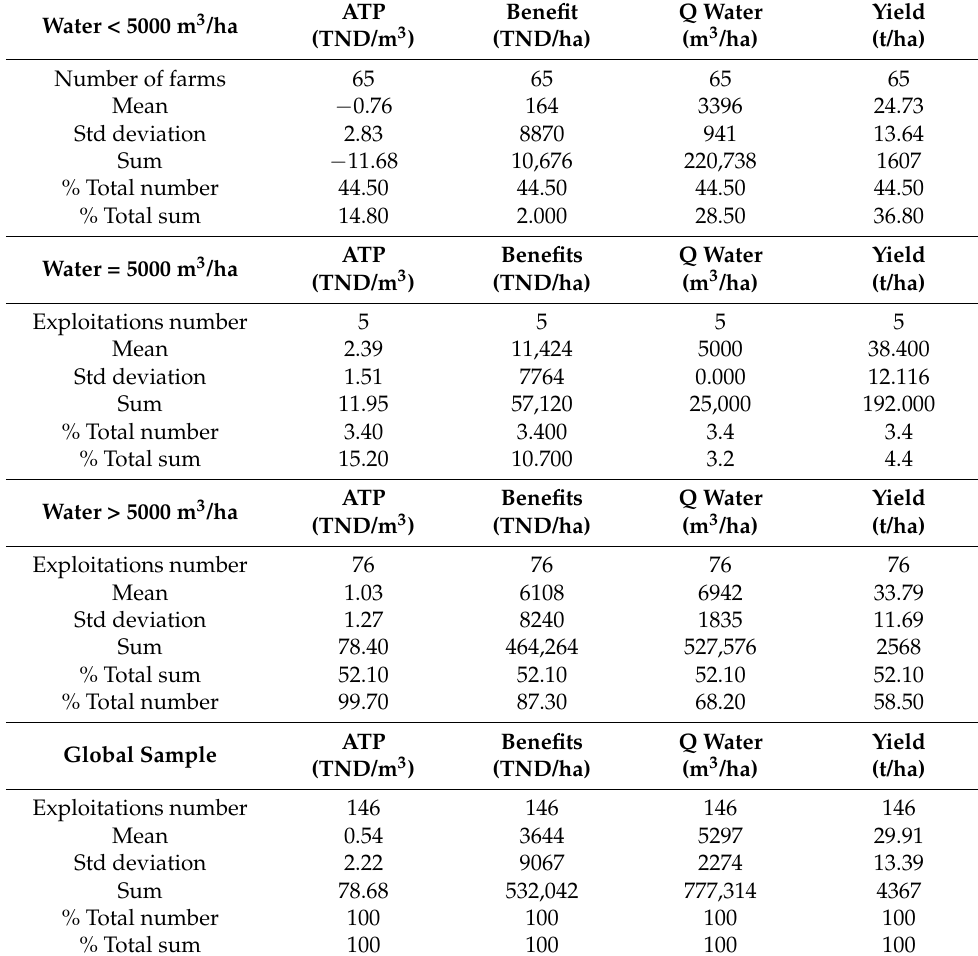
Table 2. Description of the ability to pay (ATP), benefit, water quantity (Q water) and yields.